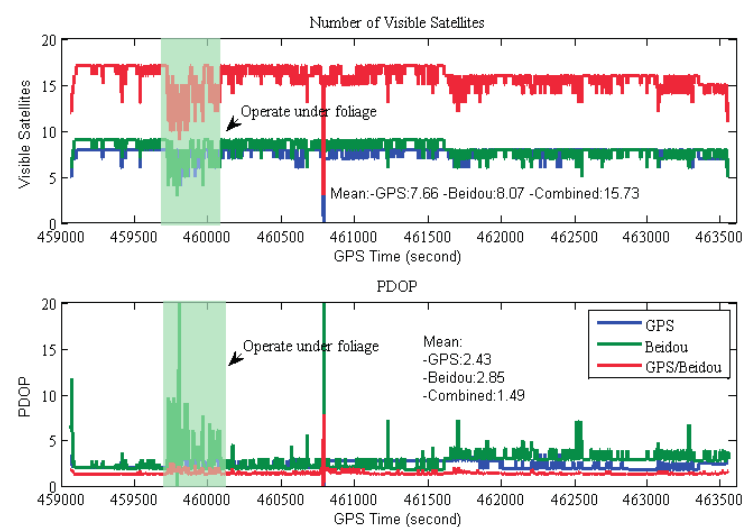
Figure 6. Satellites visibility and PDOP during the field test (15° cut-off